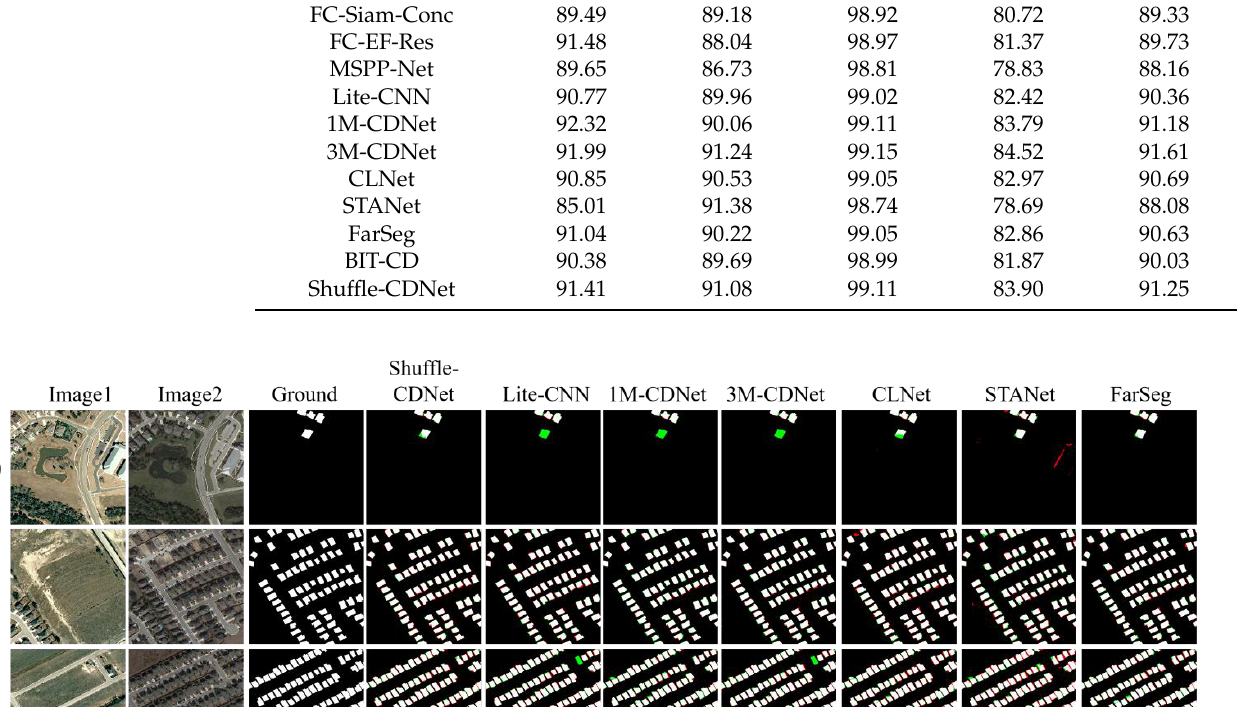
Table 3. Comparison results on the season-varying dataset. Method